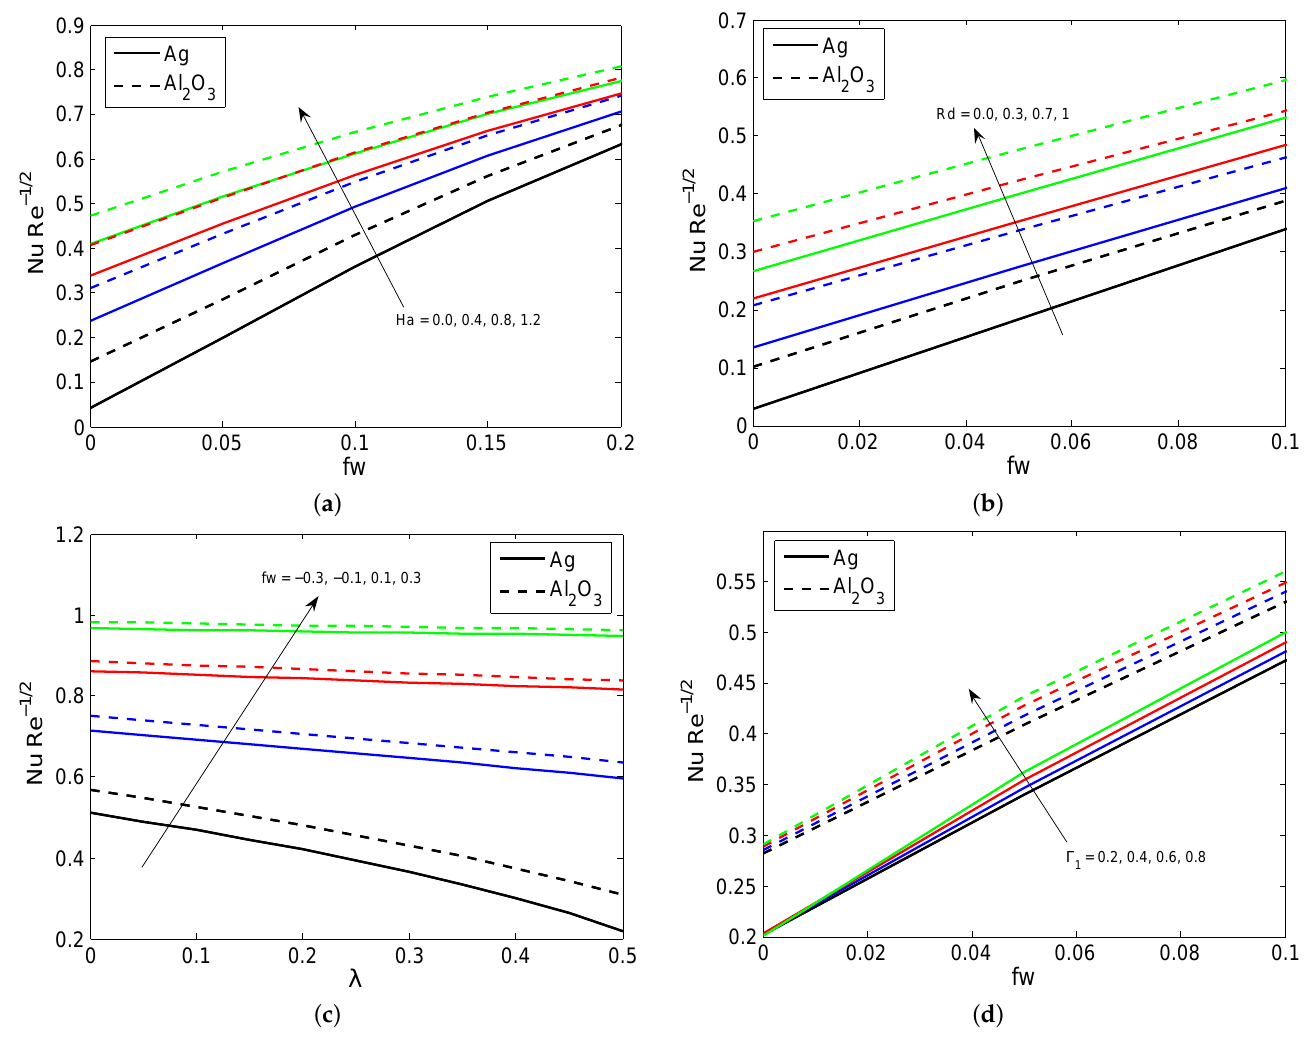
Figure 8. LNN variation for diverging values of ( a ) Ha , ( b ) Rd , ( c ) fw and ( d ) Γ 1 .